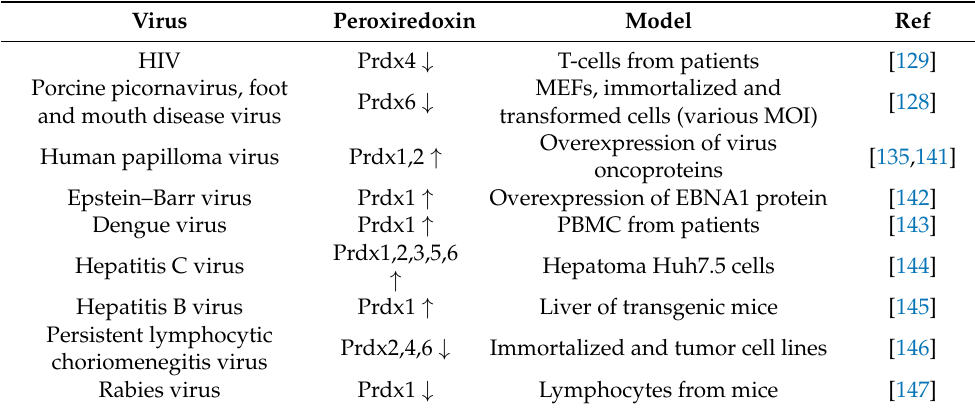
Table 4. Expression of peroxiredoxins during viral